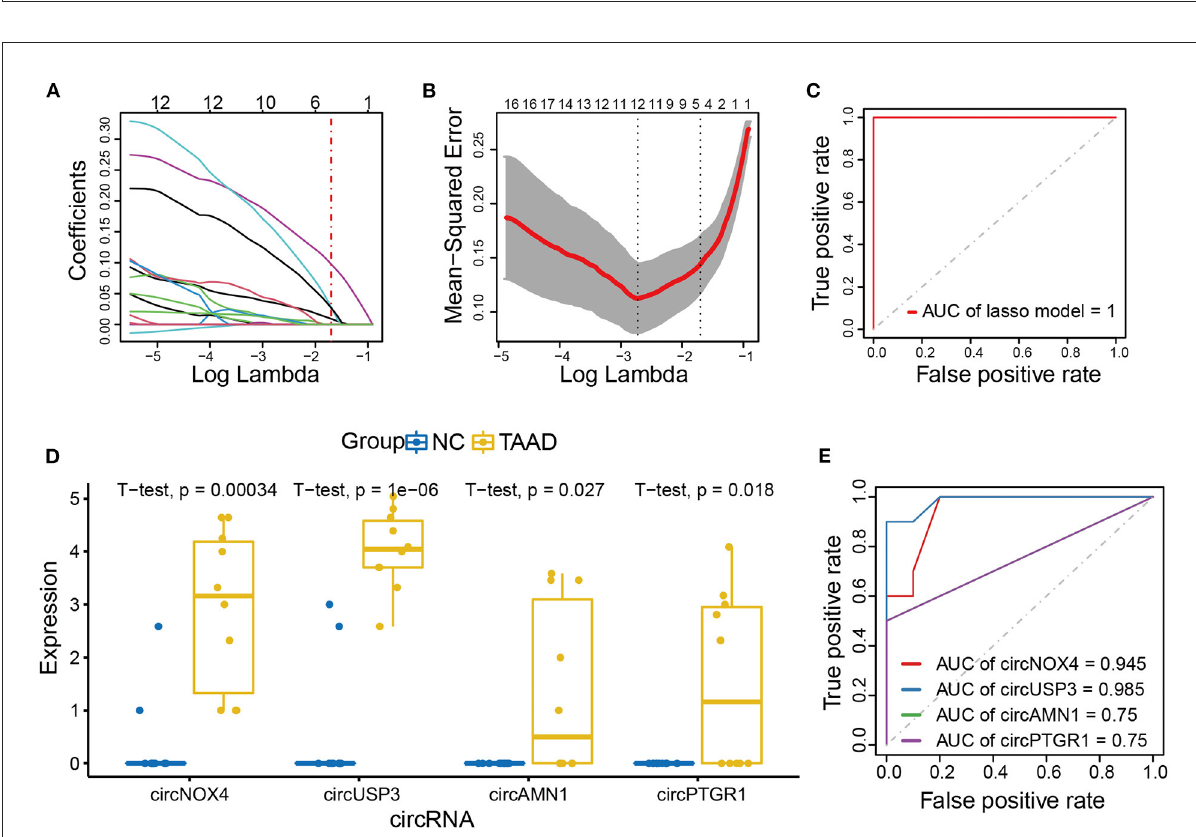
FIGURE3 CircNOX4, circUSP3, circAMN1, and circPTGR1 were the key circRNAs of TAAD. (A, B) Risk score model construction for DE circRNAs using lasso regression analysis. (A) The lasso coefficient profiles of DE circRNAs in TAAD. (B) Partial likelihood deviance was plotted against log (lambda). The vertical dotted lines indicate the lambda value with minimum error and with one standard error (SE) of the minimum. (C) ROC curve analysis of the prognostic prediction efficiency of the lasso model. (D) The boxplot of lasso model circRNAs expression. (E) ROC curve analysis of the prognostic prediction efficiency of individual circRNA in the lasso